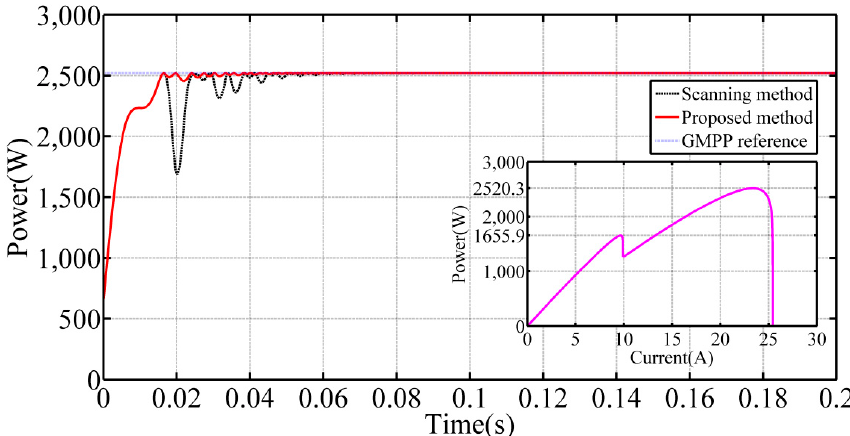
Figure 10. The GMPPT trajectories with two peaks for scanning method and optimal initial value incremental conductance (OIV-INC) algorithm under stationary shade condition, with the corresponding P − I characteristic curve.